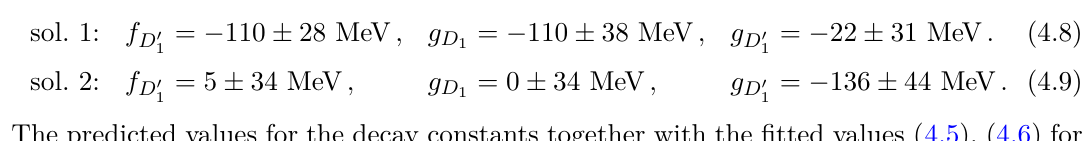
Figure 2 . The q 2 -dependence of the B → D 1 and B → D 0 68% probability envelopes in blue (green) are the results obtained using sol. 1 (sol.